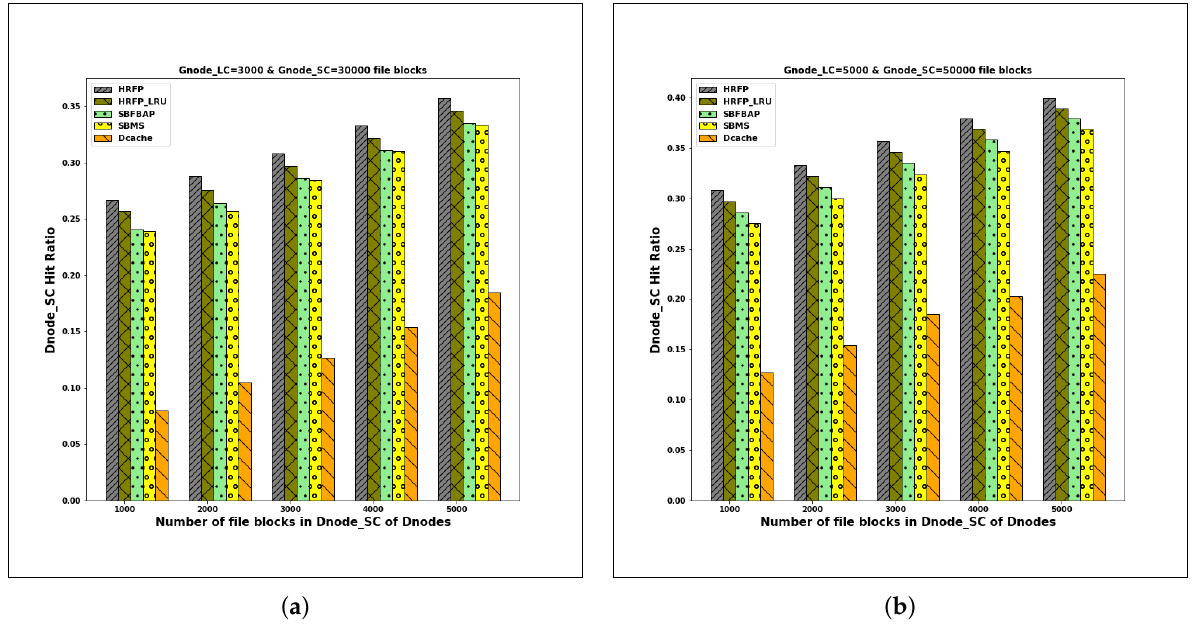
Figure 5. Figures ( a , b ) shows Hratio of Dnode_SC in Dnodes when the size of Gnode_LC is set to 3000, 5000 file blocks and size of Gnode_SC is 30,000, 50,000 file blocks respectively.